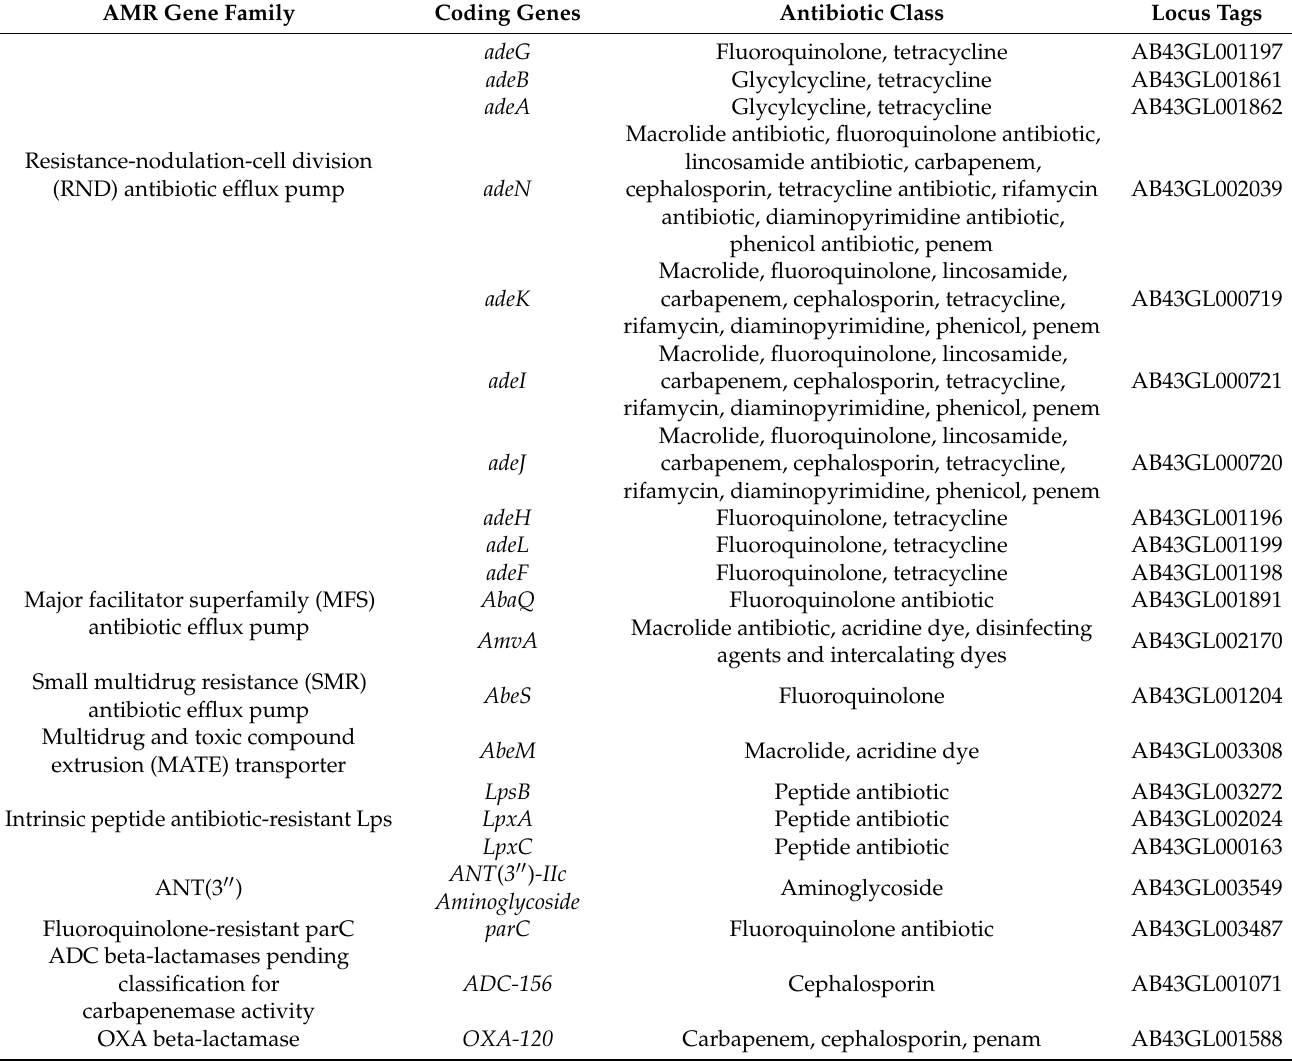
Table 2. Antibiotic resistance genes in the A. baumannii strain AB43 genome. AMR Gene Family Coding Genes Antibiotic Class Locus